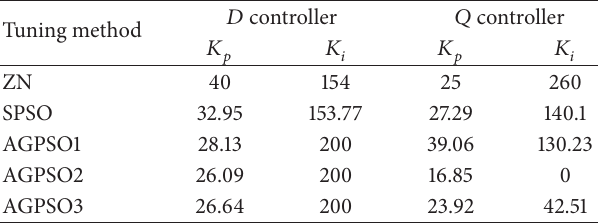
Table 4: Operating points of PI controllers for three-phase balanced fault.